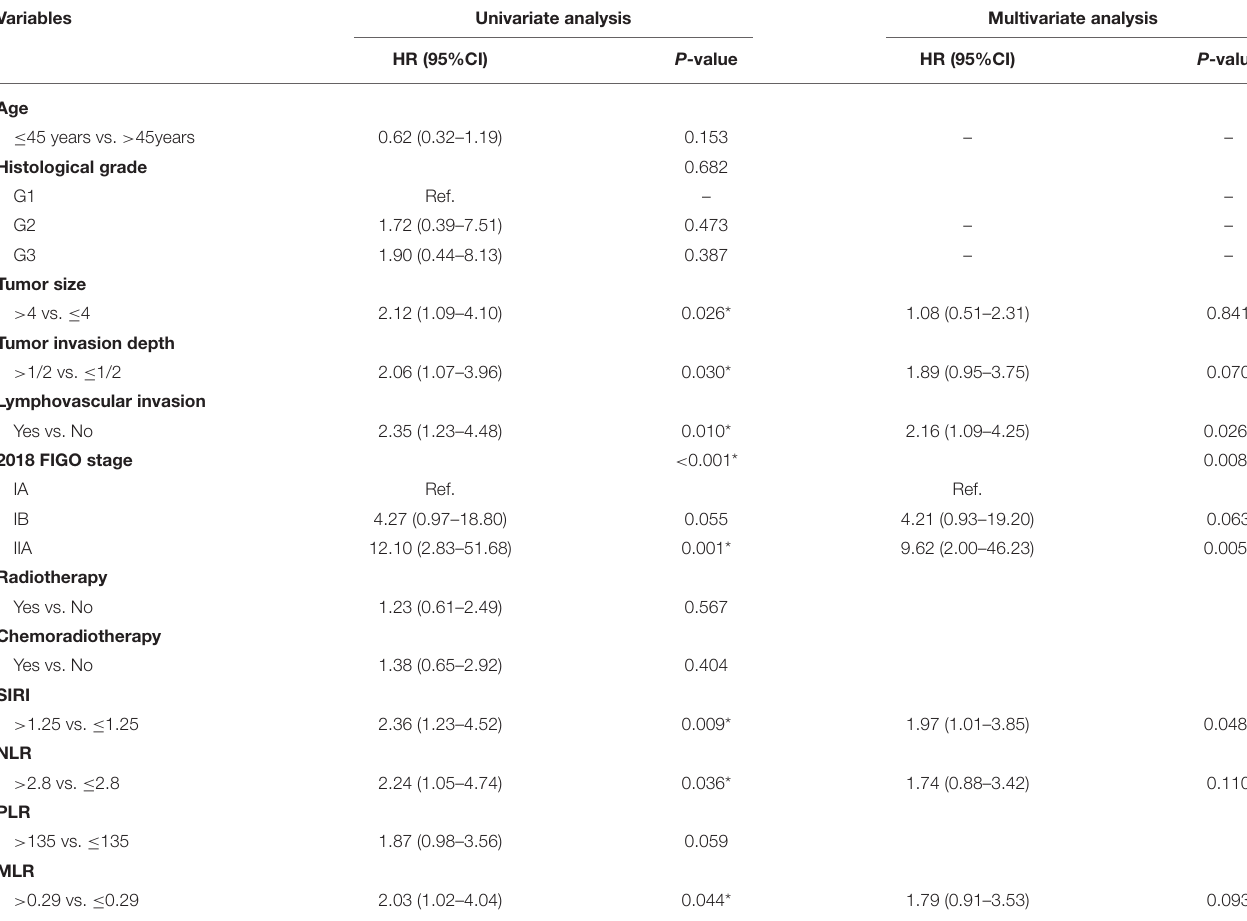
TABLE 4 | Univariate and multivariate cox regression analyses for overall survival in cervical cancer patients in validation cohort.